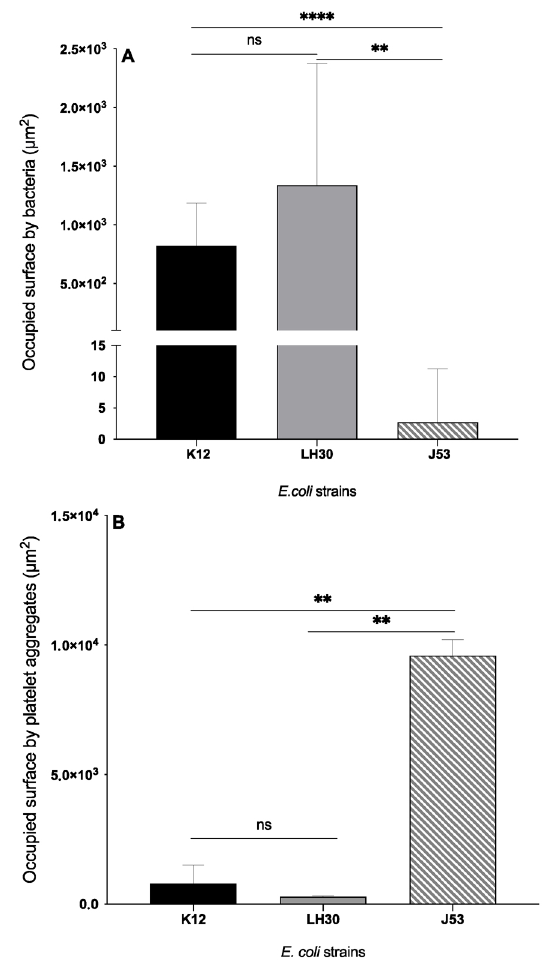
Figure 2. Occupied surface ( µ m 2 ) by bacteria ( A ) and platelet aggregates ( B ) for each E. coli strain in platelet-bacteria mixtures. ( A ): Bars represent Mean with SD. Black column: occupied sur- face by E. coli K12 (8.23 × 10 2 ± 3.64 × 10 2 ). Grey column: occupied surface by E. coli LH30 (1.34 × 10 3 ± 1.04 × 10 3 ). Striped grey column: occupied surface by E. coli J53 (2.71 ± 8.57). ( B ): Bars represent Mean with SD. Black column: occupied surface by platelet aggregates in platelets-K12 mixture (795.6 ± 710.5). Grey column: occupied surface by platelet aggregates in platelets-LH30 mixture (281.2 ± 36.71). Striped grey column: occupied surface by platelet aggregates in platelets- J53 mixture (9583 ± 630.7). **,****: significant difference. ns: non-significant. Significant differ- ences between the two groups were determined using the two-tailed, paired Student. ** p < 0.01, **** p <